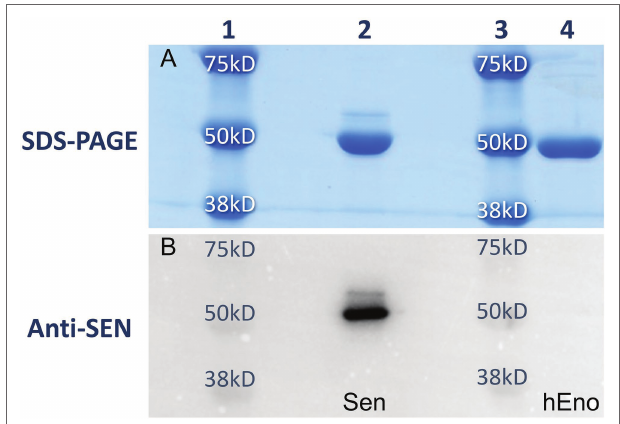
FIGURE 1 | Purities of recombinant Sen and hEno. Recombinant Sen (lane 2) and hEno (lane 4) monomeric molecular weights and purities as determined using 12% SDS-PAGE (A) and Western blotting with rabbit-anti Sen (B) . With 67% amino acid sequence similarities between these proteins, no cross- reactivity of anti Sen was observed with hEno. Lanes 1 and 3 are molecular weight standards.